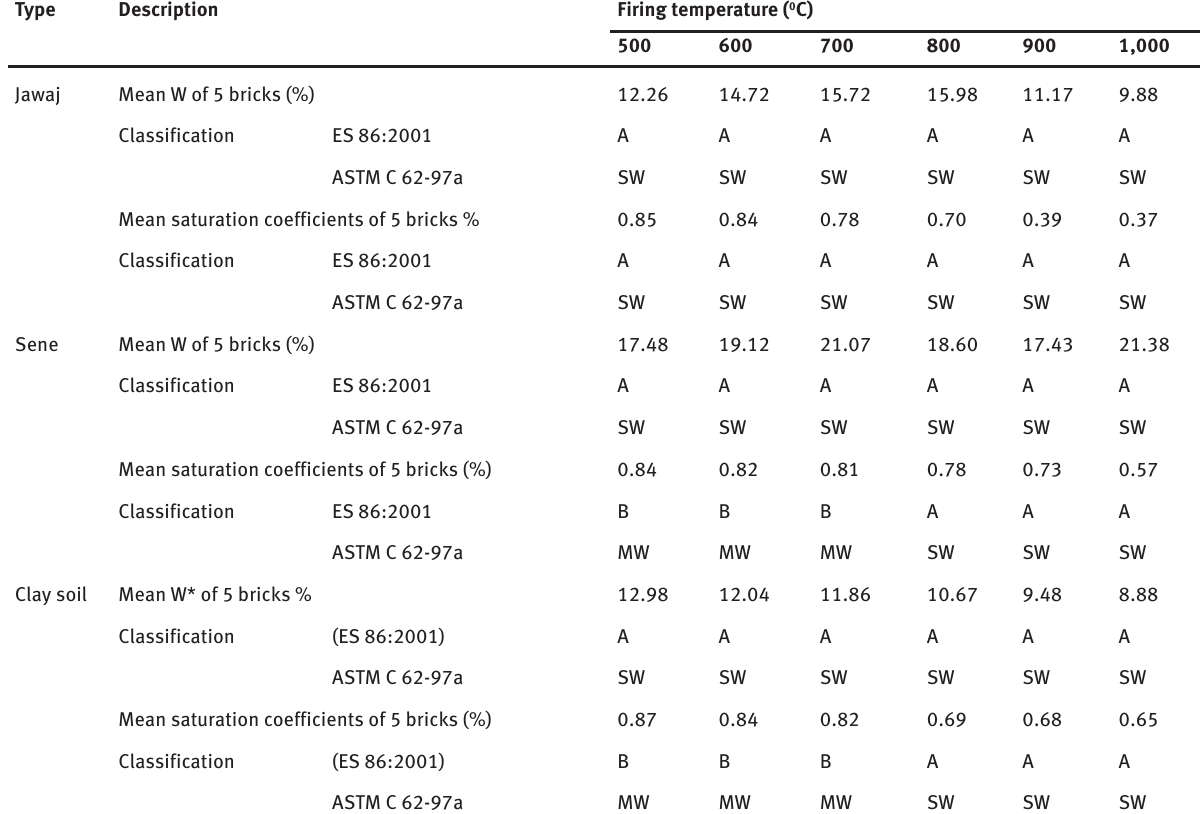
Table 6: Average water absorption and saturation coefficient of TMSs and clay soils bricks and their classification.